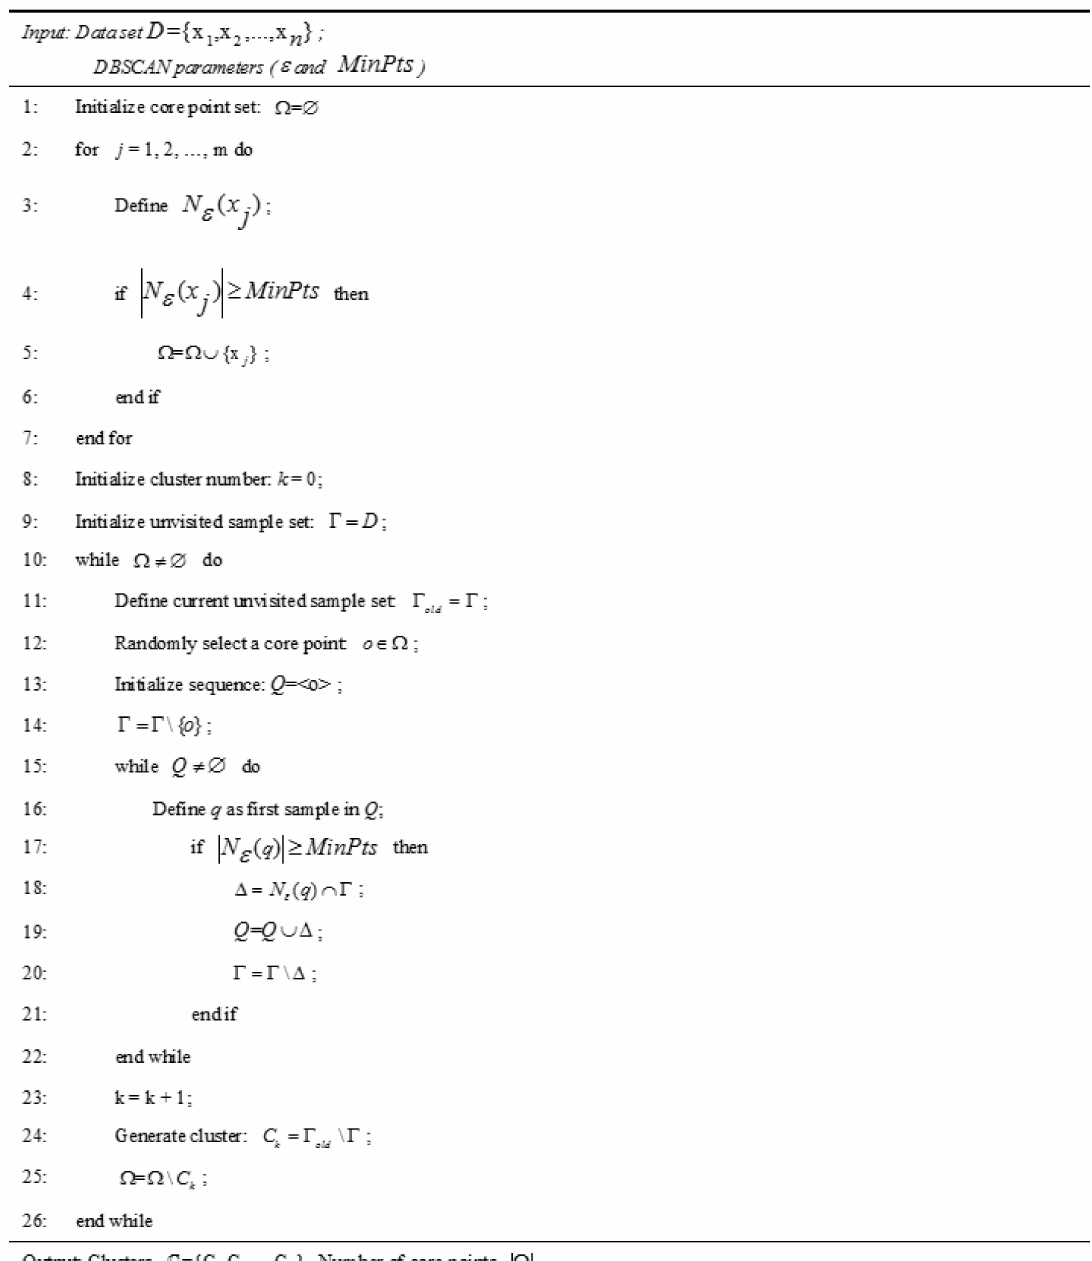
Figure A2. DBSCAN